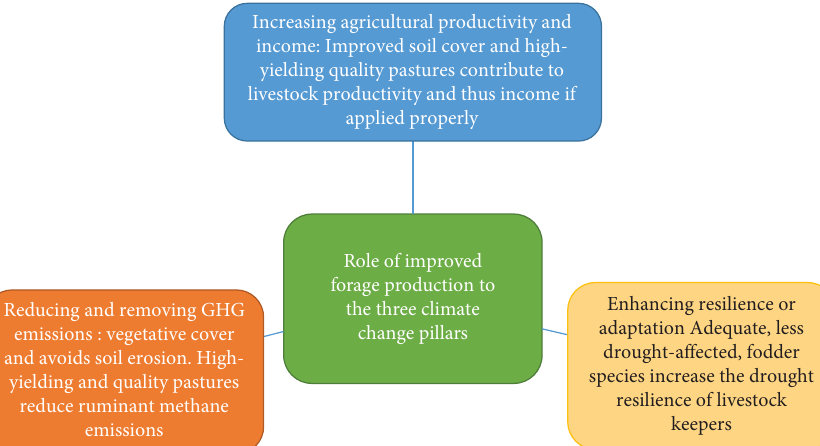
Figure 3: Role of improved forage production in the three pillars of CSA [67, 69,